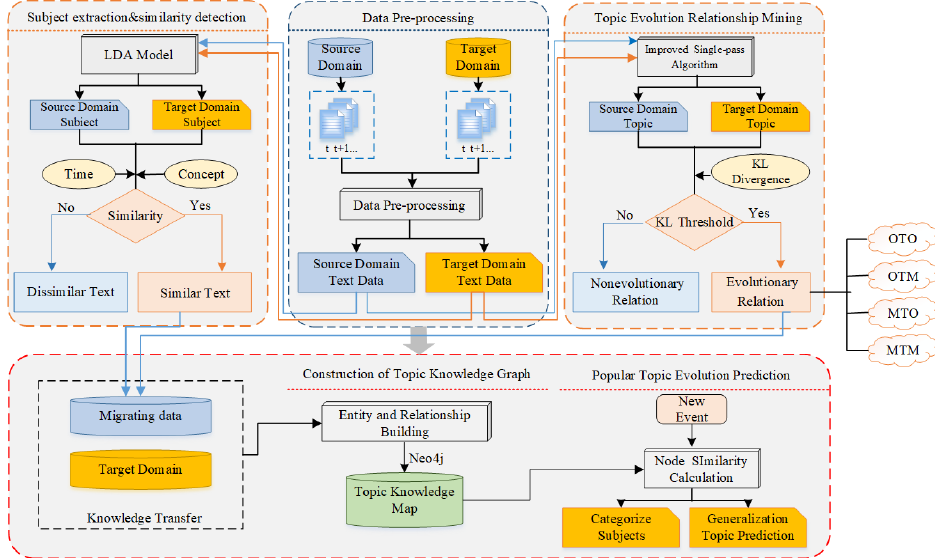
Figure 1. The basic research framework of the study. Based on the preprocessed text data: (1) For data of the same time slice, the LDA model was used to extract similar subject text data for transfer learning; (2) for data of different time slices, the single-pass algorithm was used to extract potential topics and evolutionary relationships; (3) the above results are used to construct the topic knowledge graph and predict popular topics.